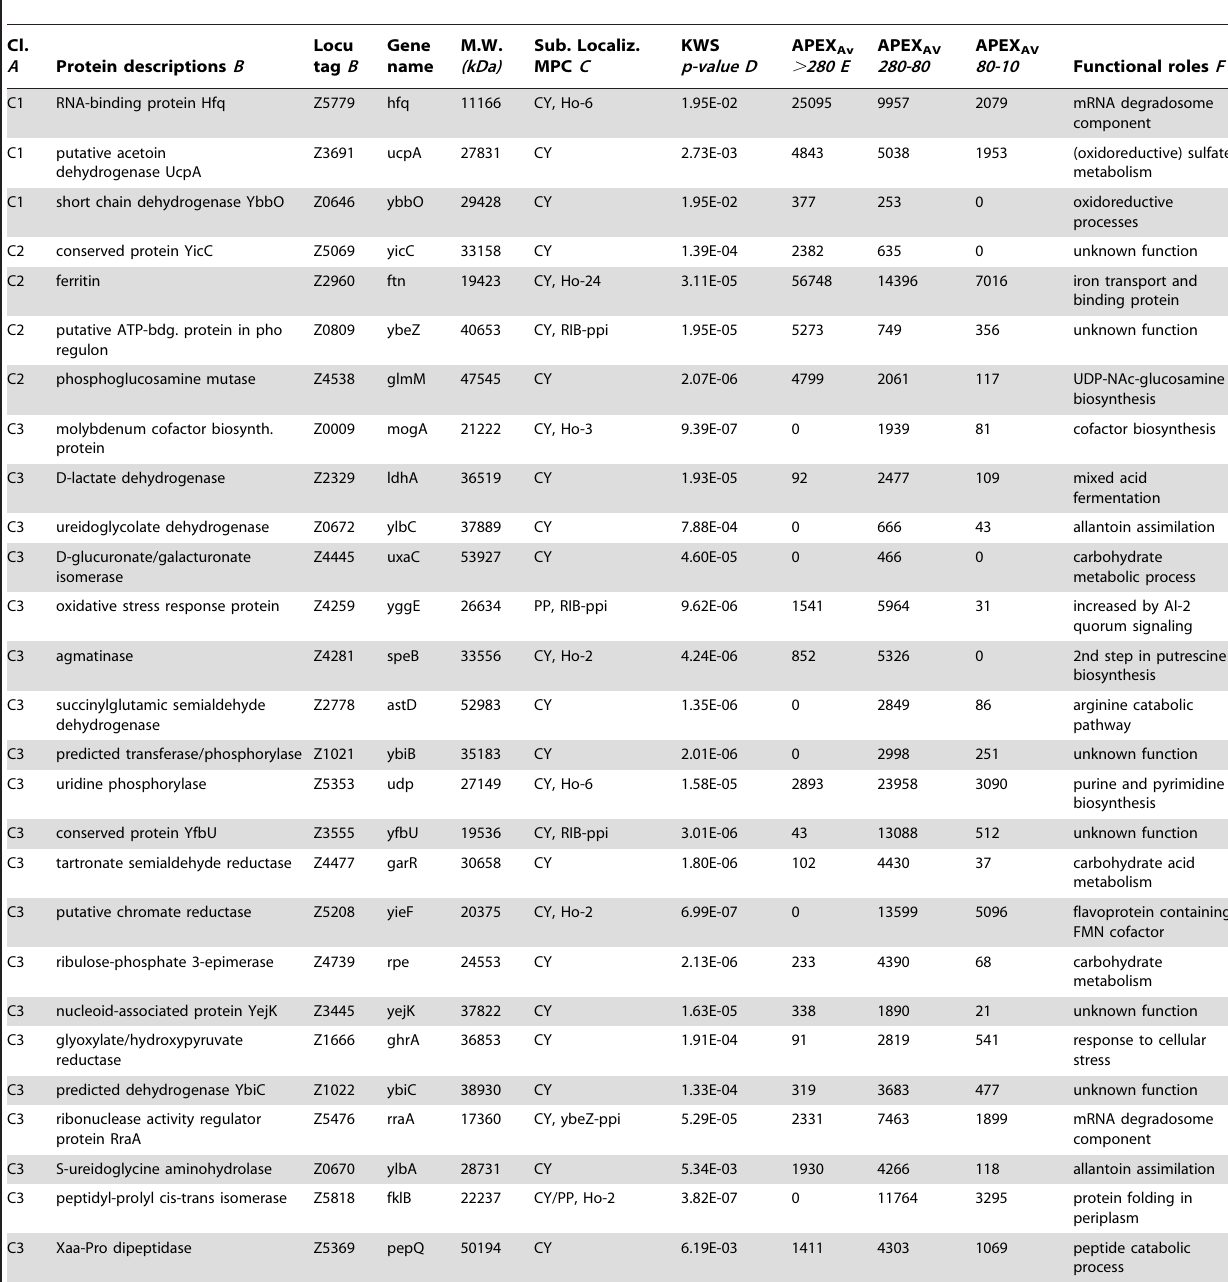
Table 2. Selection of proteins predicted to participate in di- or oligomeric complexes based on HCL analysis of SEC fraction abundance